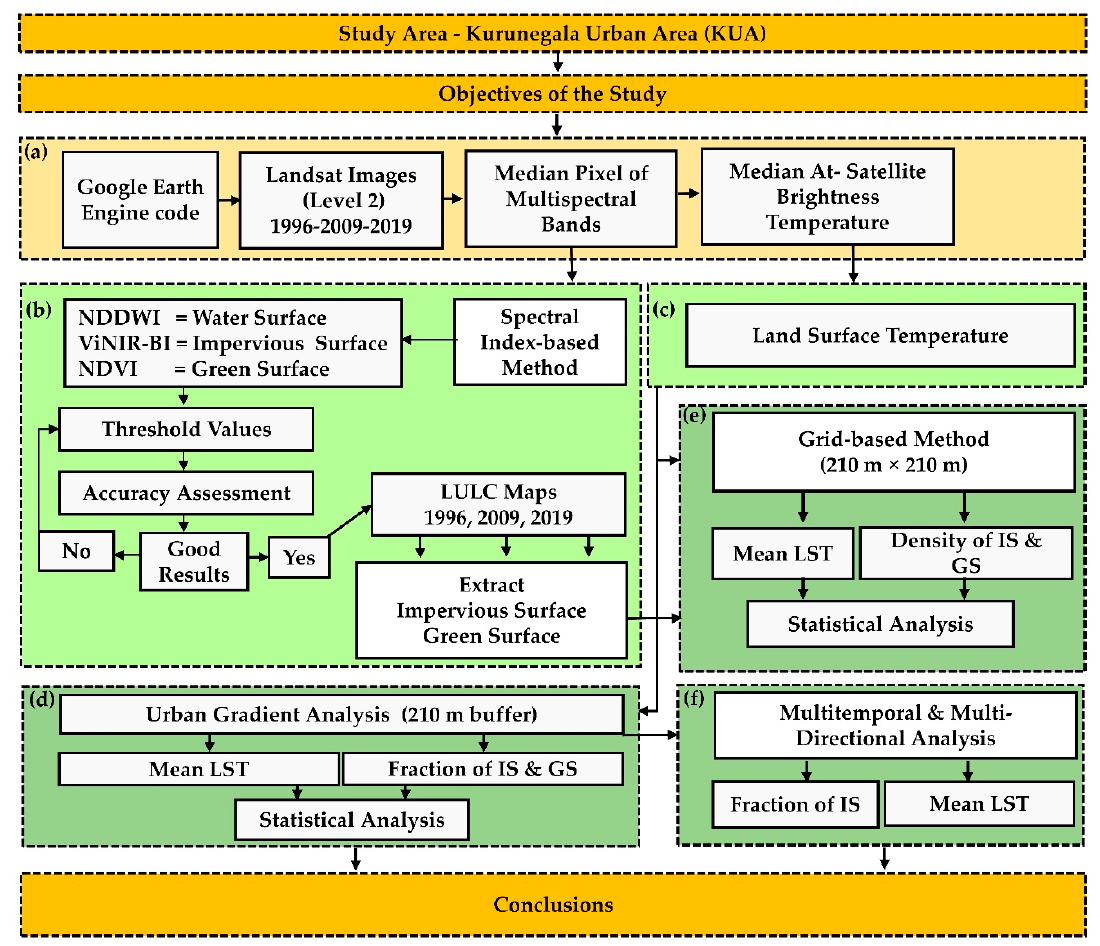
Figure 2. The workflow of the study: ( a ) use of Google Earth Engine (GEE) to extract bands of Landsat images; ( b ) land cover extraction; ( c ) Land Surface Temperature (LST) retrieval; ( d ) use of urban gradient analysis; ( e ) use of the grid-based method; and ( f ) use of multitemporal and multi-directional analysis.